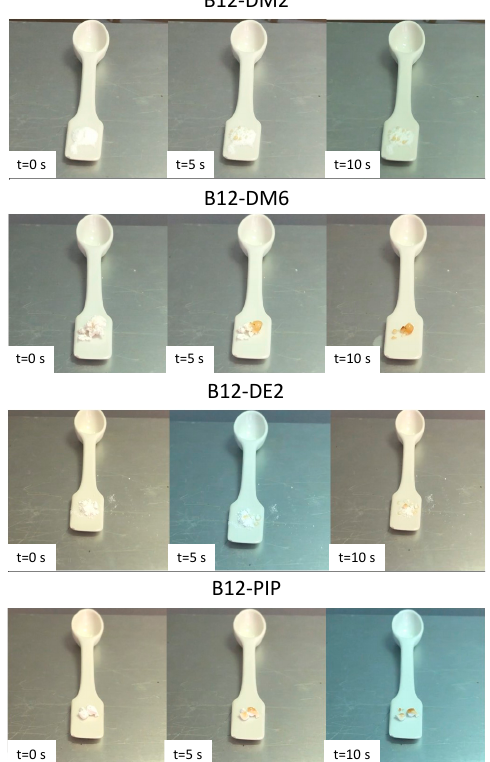
Figure 5. Snapshot of the results of ignitability tests carried out on H-PAA powders.